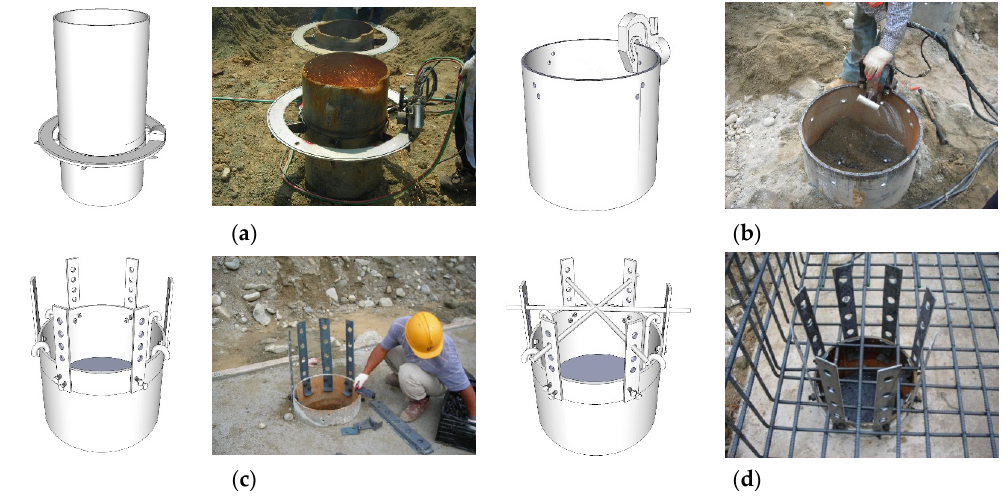
Figure 2. Perfobond shear connector for steel pile cap strengthening. ( a ) Cutting of steel pile cap. ( b ) Hole punching on the steel pile cap. ( c ) Installation of perfobond shear connectors by bolting. ( d ) Distribution of steel reinforcing bars at concrete foundation.